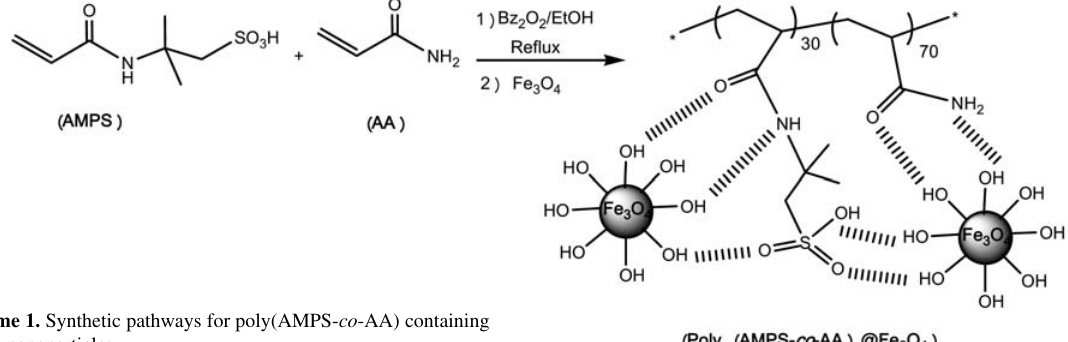
O (a), poly (AMPS- co -AA) (b), and 3 4